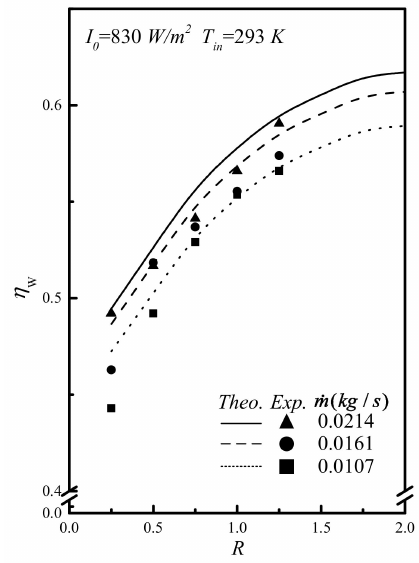
Figure 6. E ff ect of recycle ratio on collector thermal e ffi ciency.